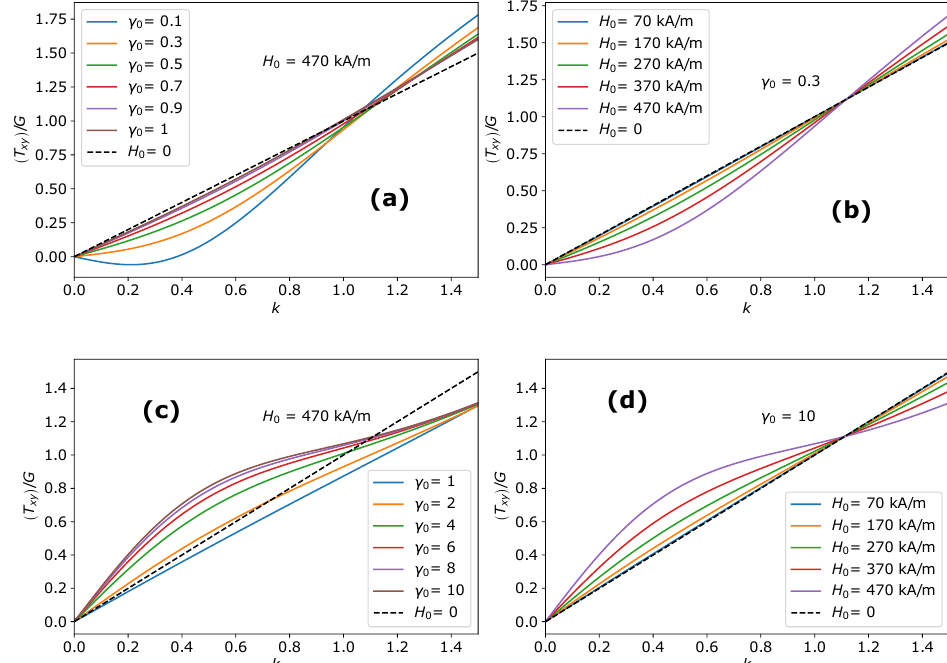
Figure 4. The stress-strain behavior of MAEs in the x - y plane: ( a ) Shear stress T xy as a function of the amount of shear k during the shear deformation along the field direction for oblate MAEs at different initial aspect ratios γ 0 . ( b ) Shear stress T xy as a function of the amount of shear k during the shear deformation along the field direction for an oblate MAE ( γ 0 = 0.3) at different magnitudes of the applied magnetic field (cid:126) H 0 . ( c ) Shear stress T xy as a function of the amount of shear k during the shear deformation perpendicular to the field direction for prolate MAEs at different initial aspect ratios γ 0 . ( d ) Shear stress T xy as a function of the amount of shear k during the shear deformation perpendicular to the field direction for a prolate MAE ( γ 0 = 10) at different magnitudes of the applied magnetic field (cid:126) H 0 .